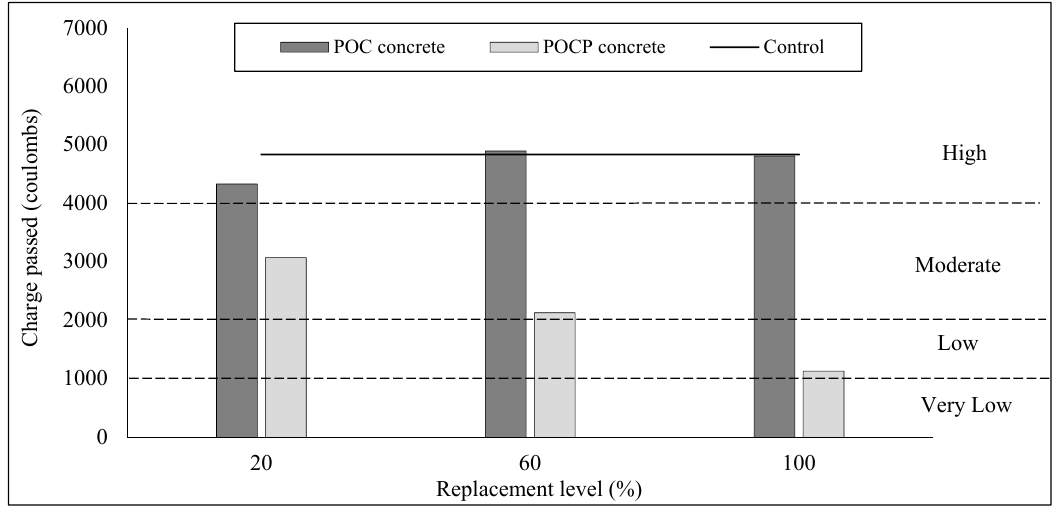
Figure 30. 28-day charge passed coulombs value of POC and POCP concretes.